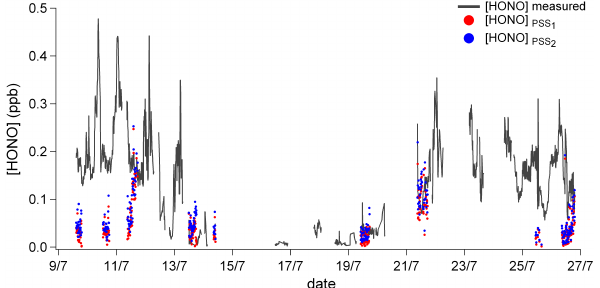
Fig. 5. Observed HONO mixing ratios (black lines) compared with PSS calculations (red circles for Eq. 1 and blue circles for Eq. 2) for the MEGAPOLI summer campaign. The calculations with the PSS approach are carried out only when all the parameters used in it are available.